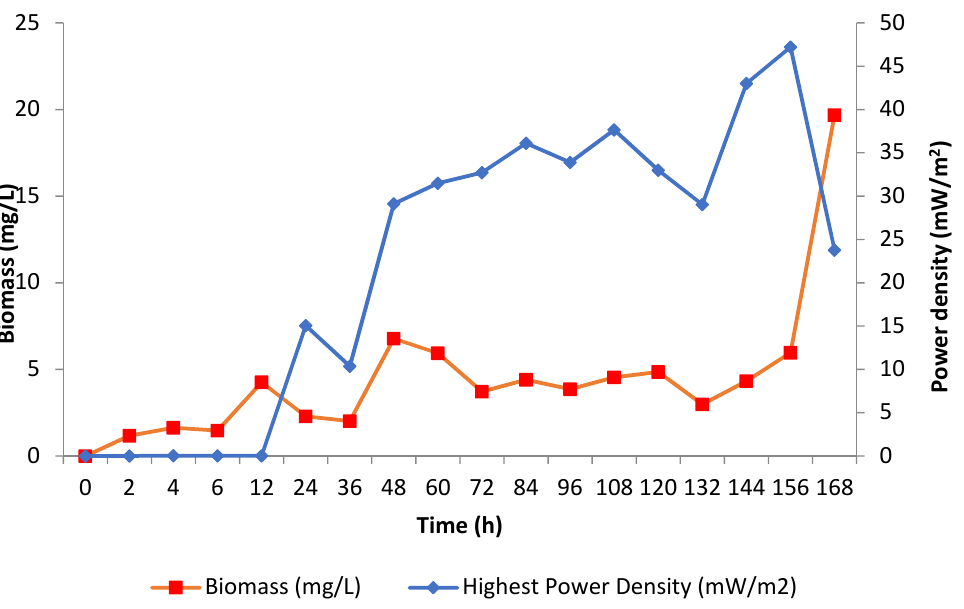
Figure 13. Profile of biomass and power density generation during the incubation period.